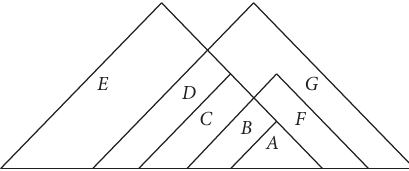
Figure 3: The relationships among AG-( r,l )-Loop and AG-( l,l )-